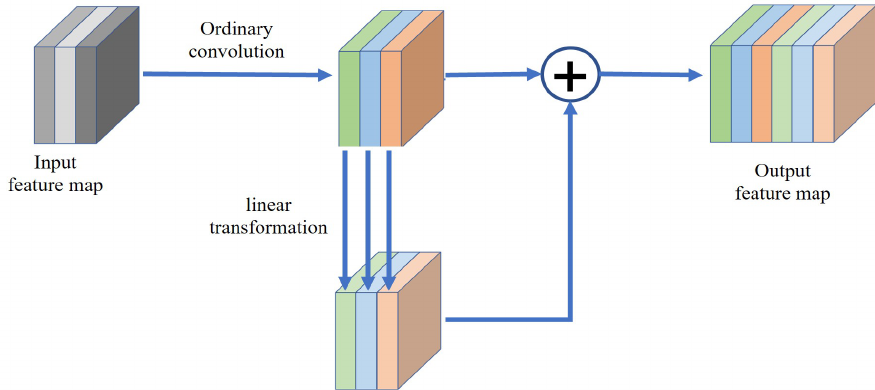
Figure 7. Ghost module structure; “+” means that the output results of the previous stage are